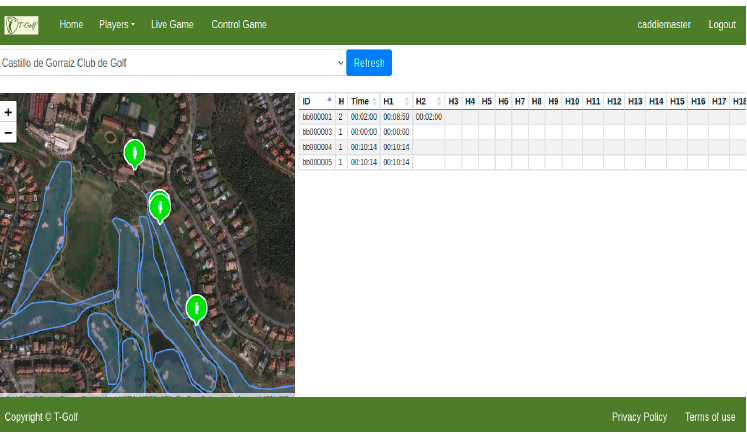
Figure 21. Real-time monitoring of the rounds and localization of players during the test under real conditions.